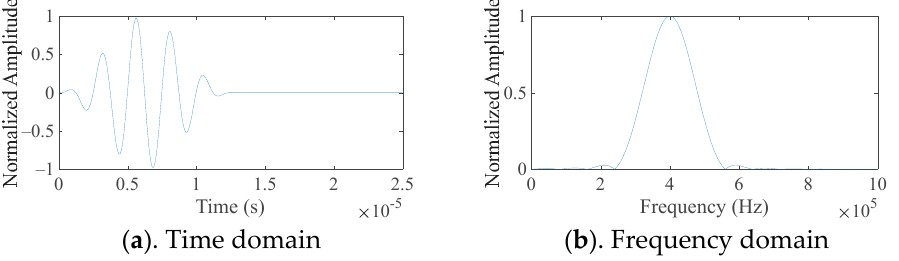
Figure 6. Excitation Signal Centered at 400 kHz.